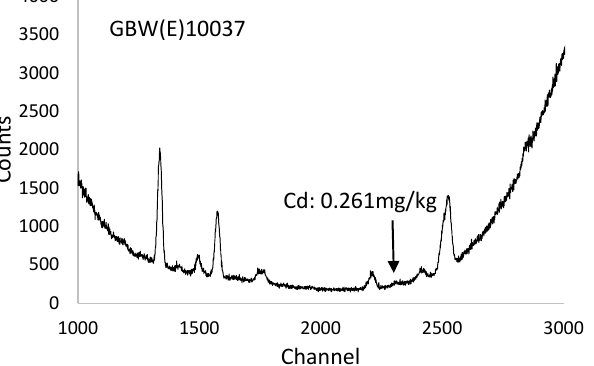
Figure 1. The average XRF spectrum of GBW(E)100377. The spectrum between channels 1000 and 3000 was intercepted to clearly visualize the cadmium peak.